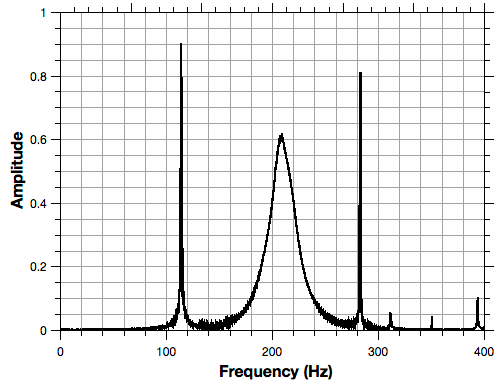
Figure 2. The oscillations inside the initial cylinder.